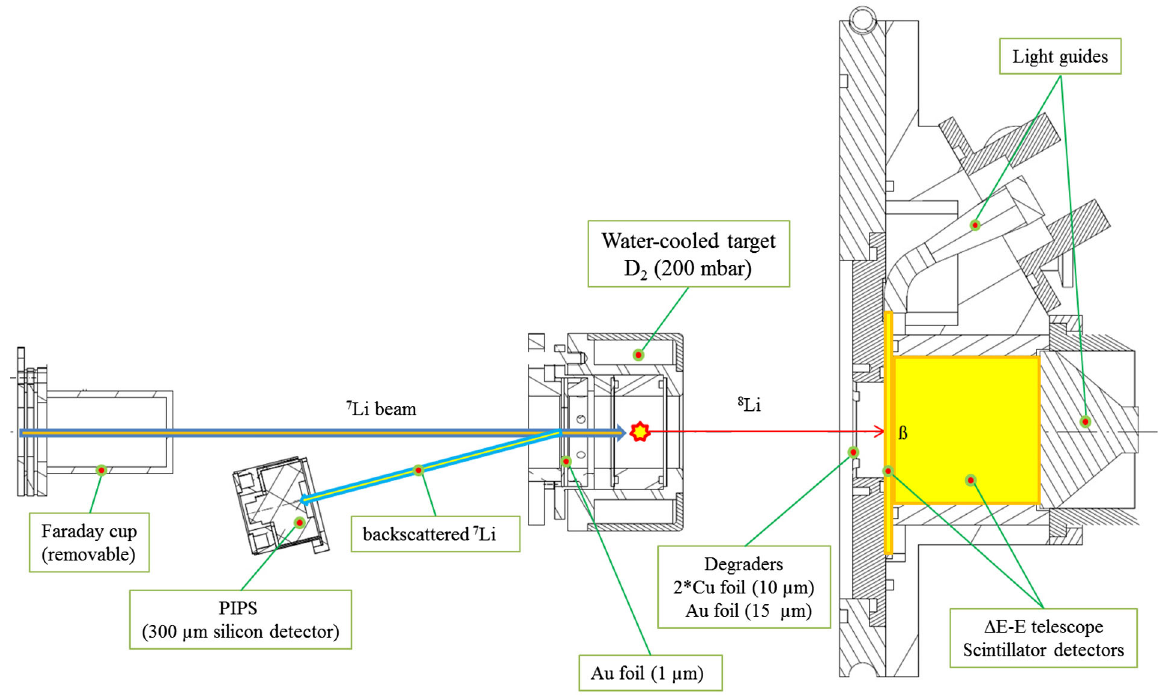
FIG. 12. Experimental setup without collection device.